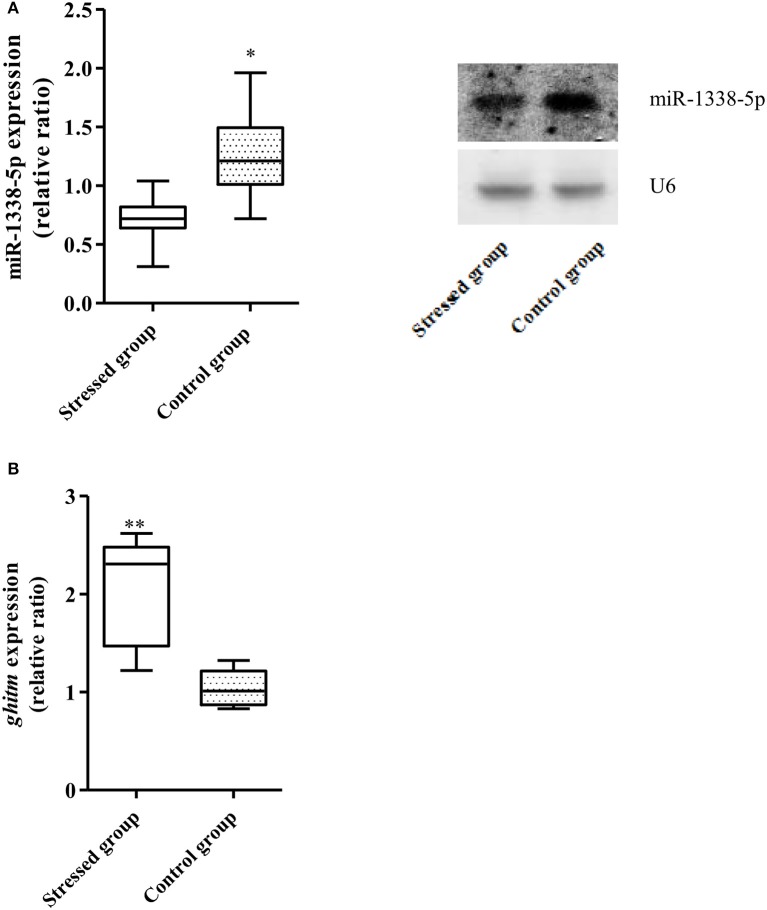
Expression of miR-1338-5p and ghitm in GIFT between 37.5°C heat-treated and control samples at 24 h (n = 9–12 replicates per group). (A) Expression of miR-1338-5p in the heat-stressed and control samples by qRT-PCR and northern blot. Values are expressed as the relative ratio with U6 as an internal control. (B) Expression of ghitm in the heat-stressed and control samples by qRT-PCR. Values are expressed as the relative ratio with 18S rRNA as an internal control. *P < 0.05 and **P < 0.01, by Duncan's multiple range test.